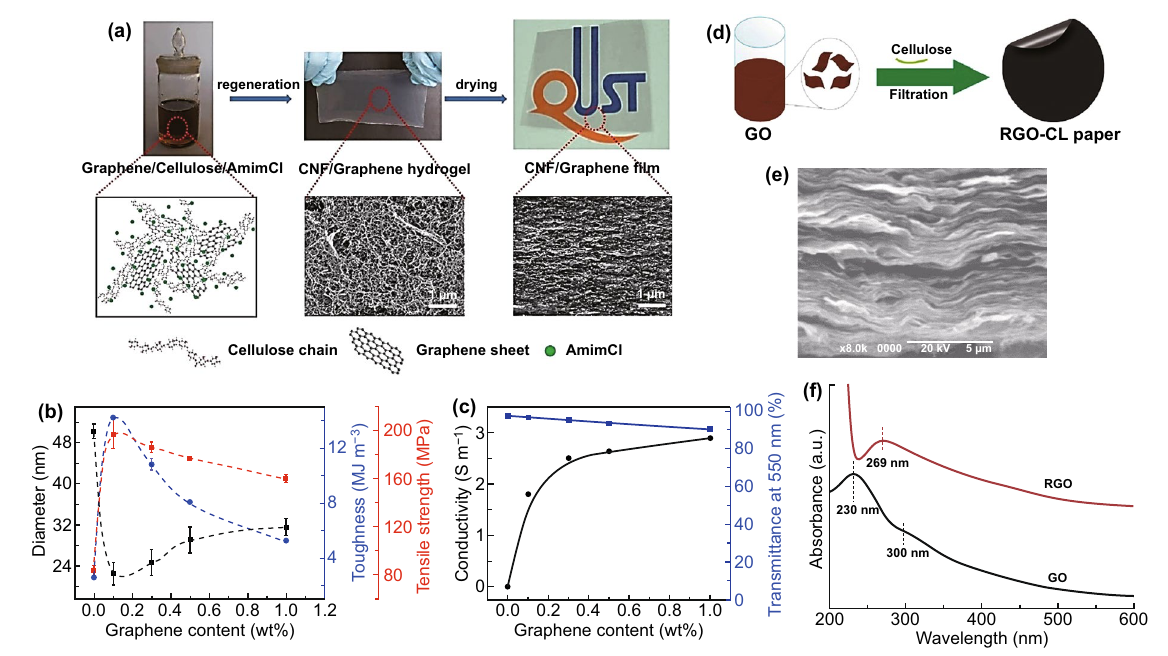
Fig. 11 a Schematic view of in-situ regeneration of CNFs-Graphene hybrid nanocomposite via [Amim]Cl. b Mechanical properties of CNFs- Graphene hybrid film with CNFs dimension and GOs content. c Electrical conductivity and optical transparency of CNFs-Graphene hybrid film with different GO content. Reproduced with permission from Ref. [136] Copyright © 2017 American Chemical Society. d Schematic view of eco-friendly reduction of GO via [Bmim]Cl and combined with NCs. e SEM microstructural images of a fabricated NCs-rGO hybrid film by vacuum filtration with [Bmim]Cl. f UV−Vis absorption spectra of GO (0.1 mg mL −1 ) before and after the reduction with NCs. Reproduced with permission from Ref. [120] Copyright © 2012, American Chemical